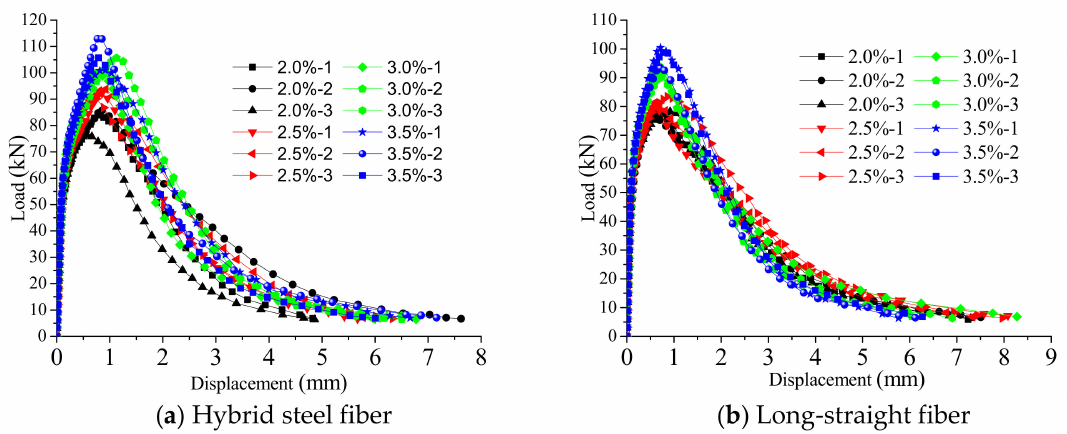
Figure 3. Load–midspan-displacement curves of four-point bending tests.